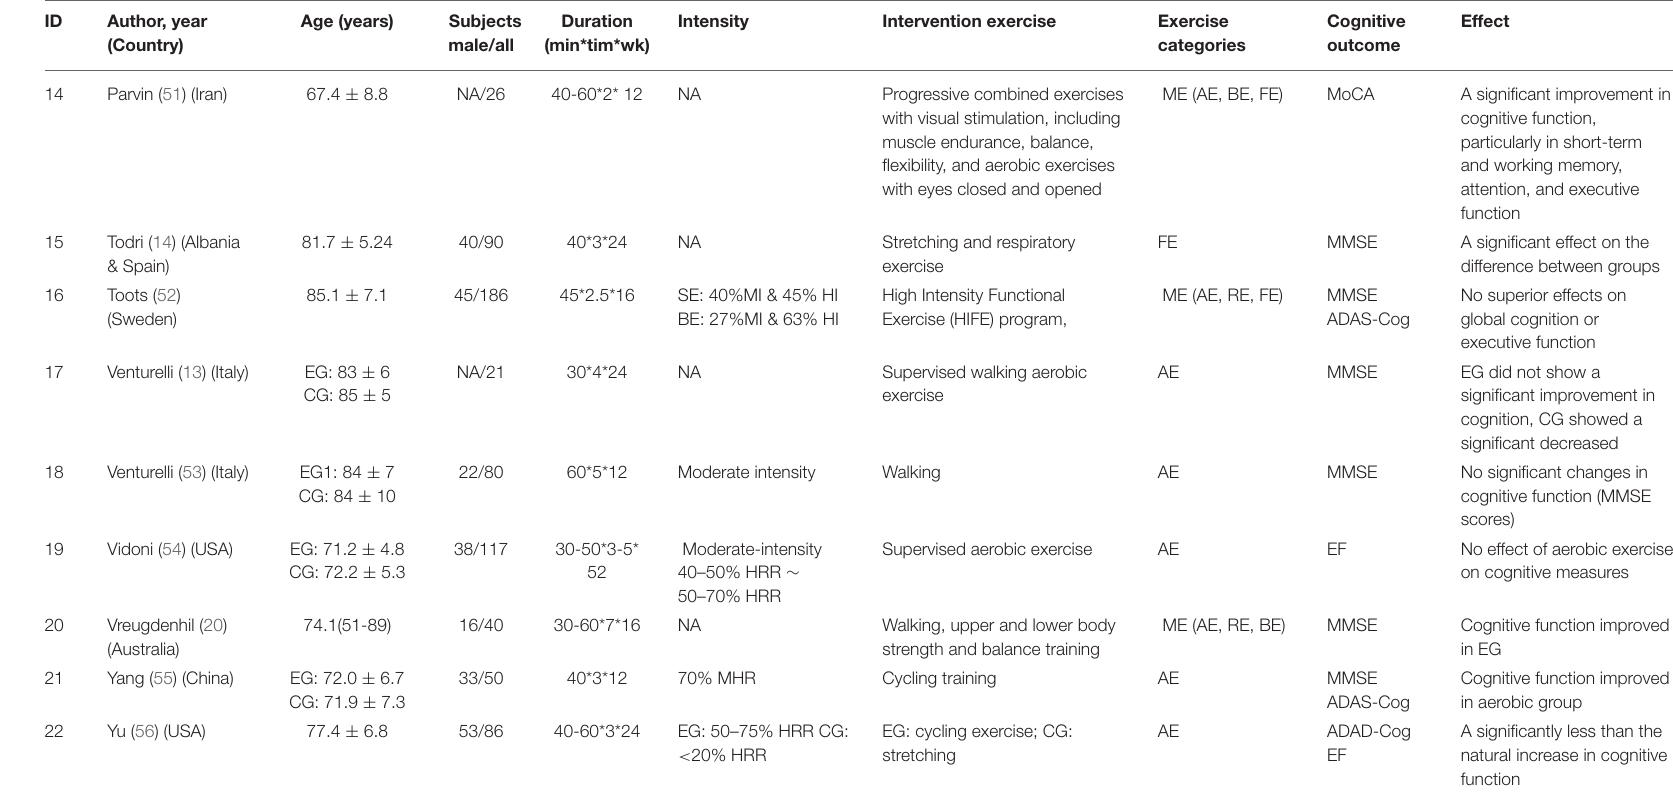
EG: cycling exercise; CG: stretching